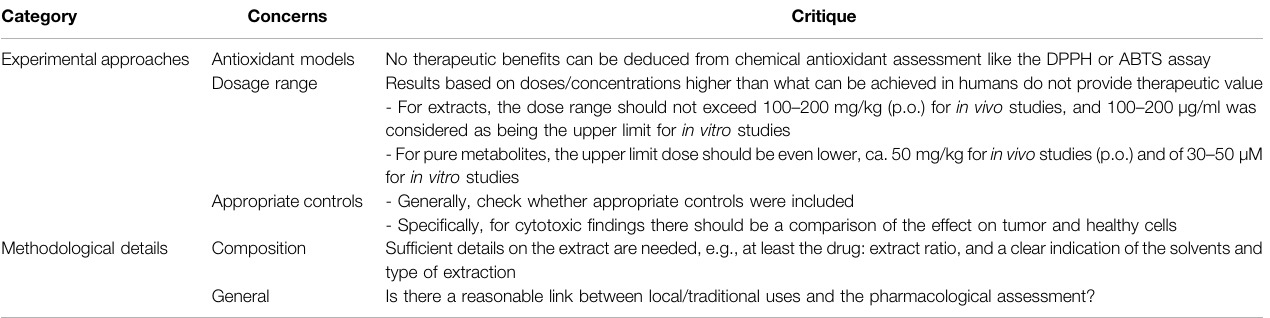
TABLE 1 | Criteria for the exclusion of studies which are considered to be of limited relevance in a pharmacological context (based on Heinrich et al., 2020). Category